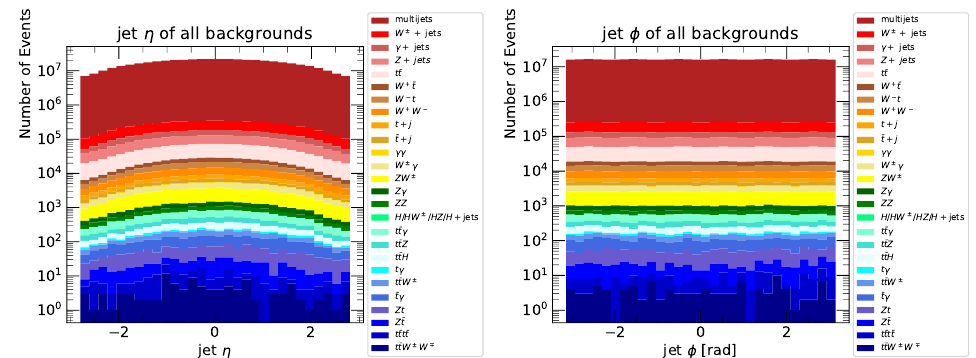
Figure 3: Pseudorapidity η (left) and azimuthal angle φ (right) of the jets for all backgrounds.